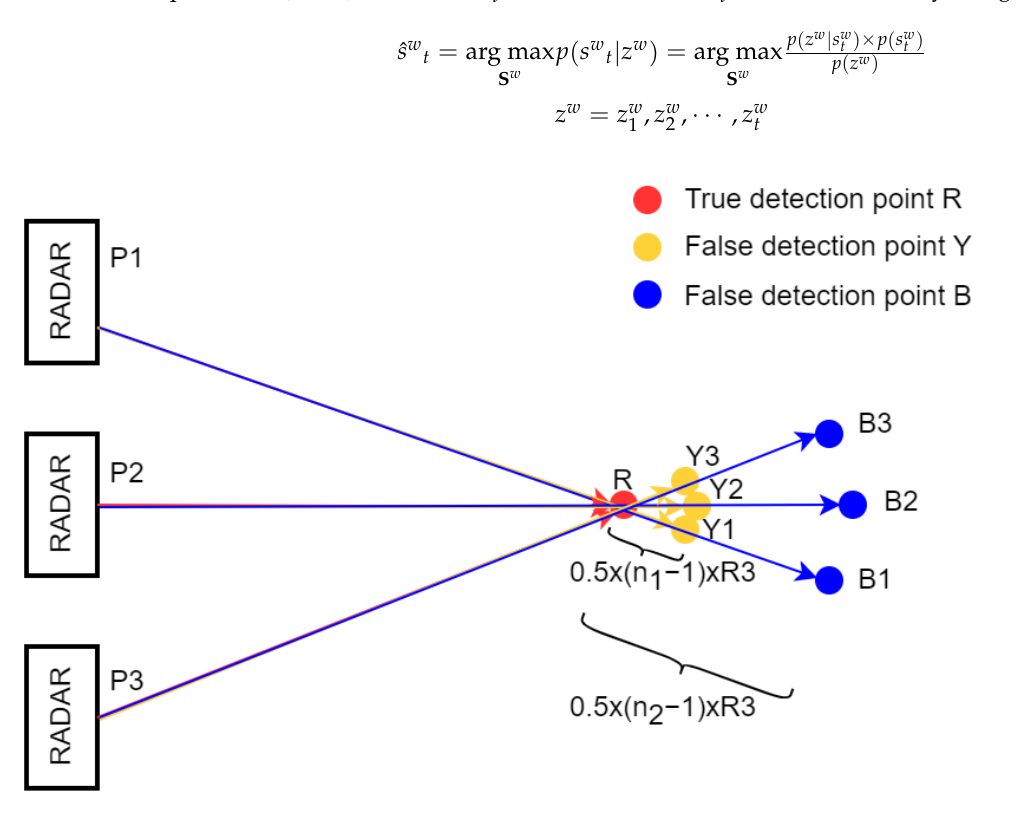
Figure 4. The scheme of detected radar point clouds of the same target in the process of radar movement with different scattering paths.